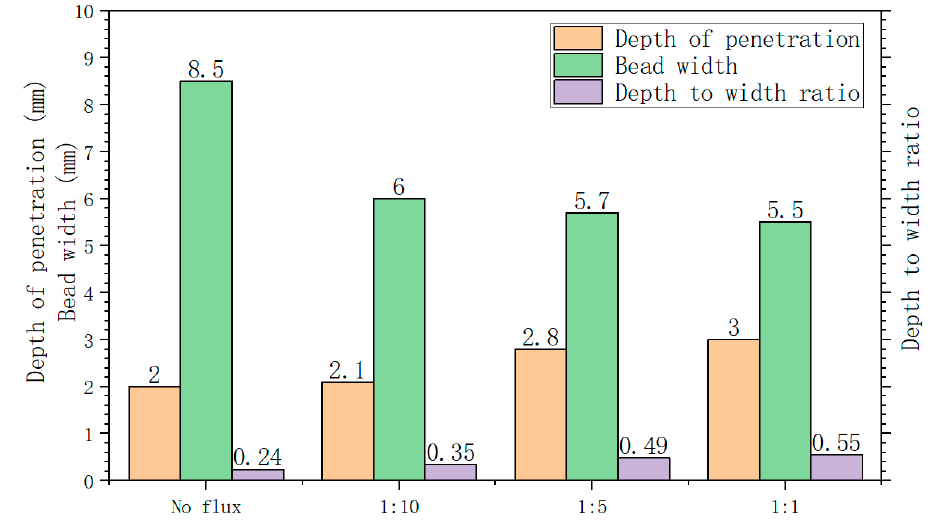
Figure 5. Weld bead geometry variation on different concentration fluxes ( d / w ratio).